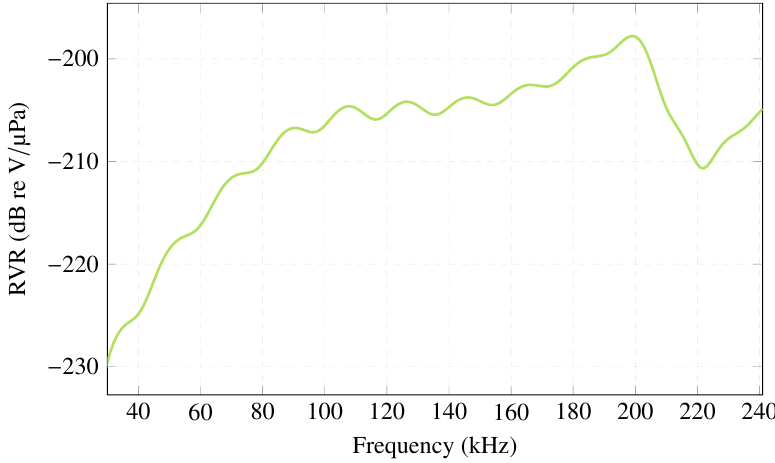
Figure 4. RVR simulated in COMSOL Multiphysics for PIC 255 ceramic, R = 5mm and h =